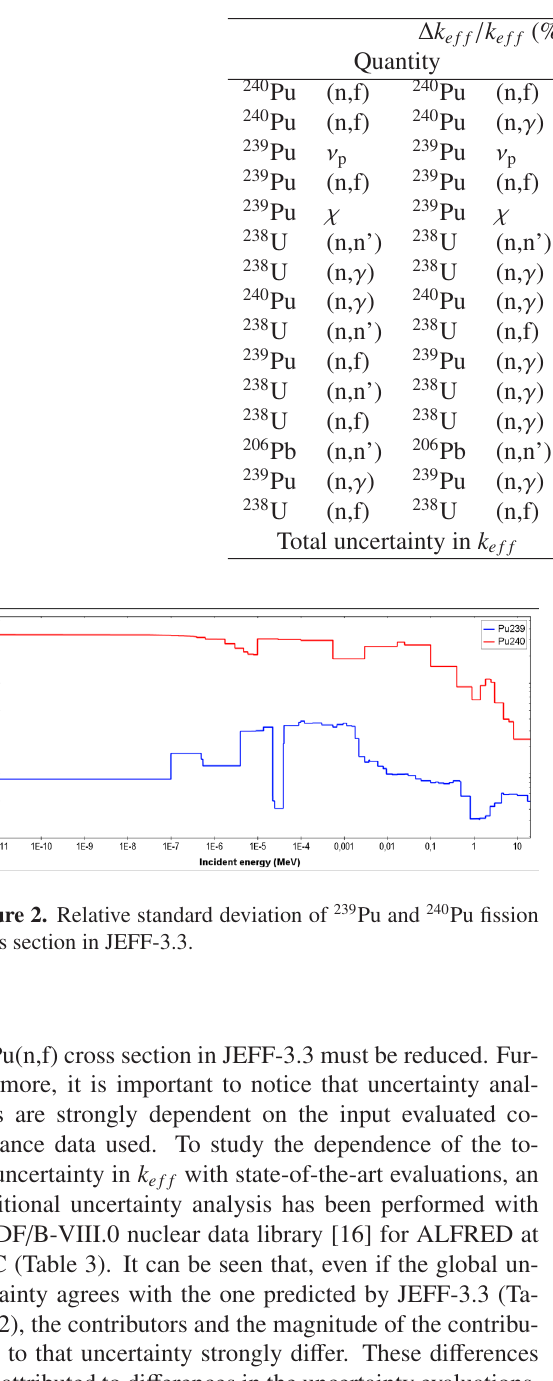
Table 2. k ef f uncertainty quantification for ALFRED at BoL, BoC and EoC with JEFF-3.3.